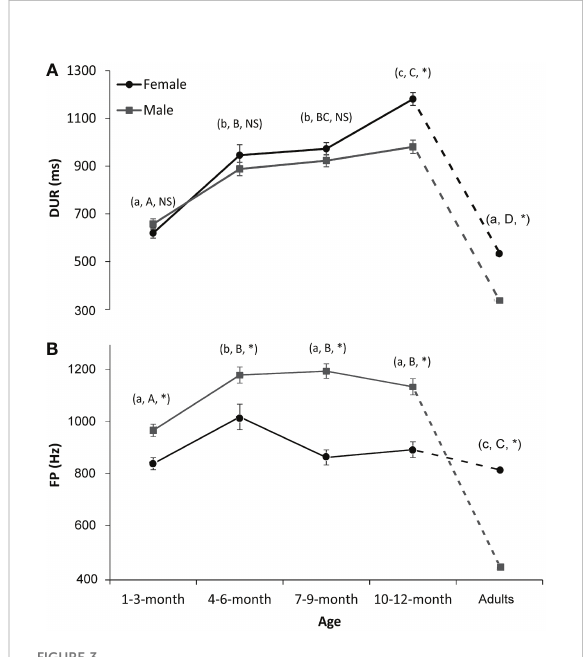
FIGURE 3 Interaction effects on the sound parameters of spotted seals. (A) Duration (DUR). (B) Peak frequency (FP). The dark lines/ dotted lines and circles represent the results for females, while the gray lines/dotted lines and squares represent the results for males. Lowercase letters in the parentheses indicate the comparison results of each sound parameter of female seals among fi ve age groups (i.e., 1 – 3, 4 – 6, 7 – 9, and 10 – 12 months old and adults). Groups with different lowercase letters indicate a signi fi cant statistical difference between them, while those with the same letter indicate no statistical difference. Similarly, uppercase letters in the parentheses indicate the comparison results for male seals. NS denotes no signi fi cance between sexes in that age group, while * denotes signi fi cance. A p -value < 0.05 is considered statistically signi fi